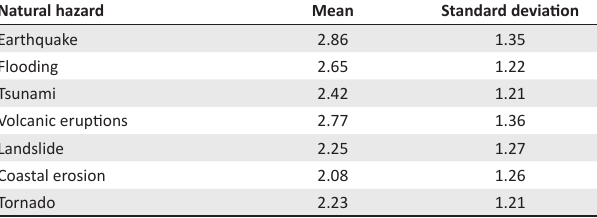
TABLE 2: Mean summary: Perception of risk and the likelihood of individuals being affected by natural hazards. Natural hazard